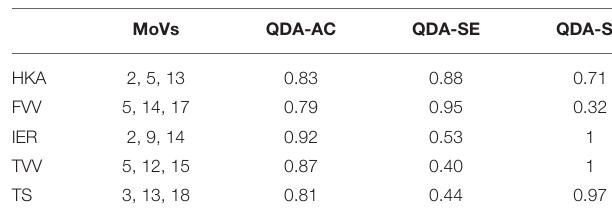
TABLE 4 | The three most representative SSM parameters for quadratic discriminant